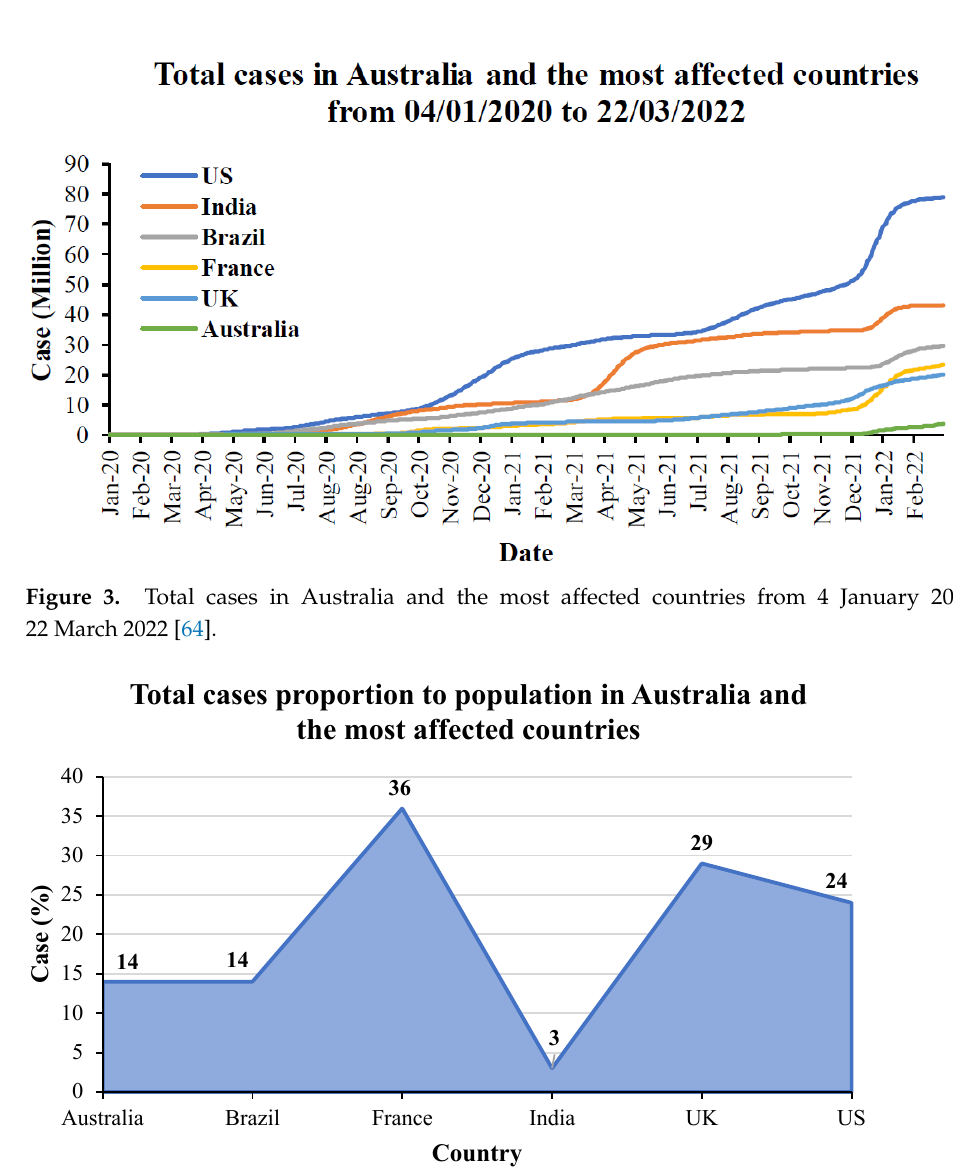
Figure 4. Total cases in proportion to population in Australia and the most affected countries from the first emergence to March 2022.